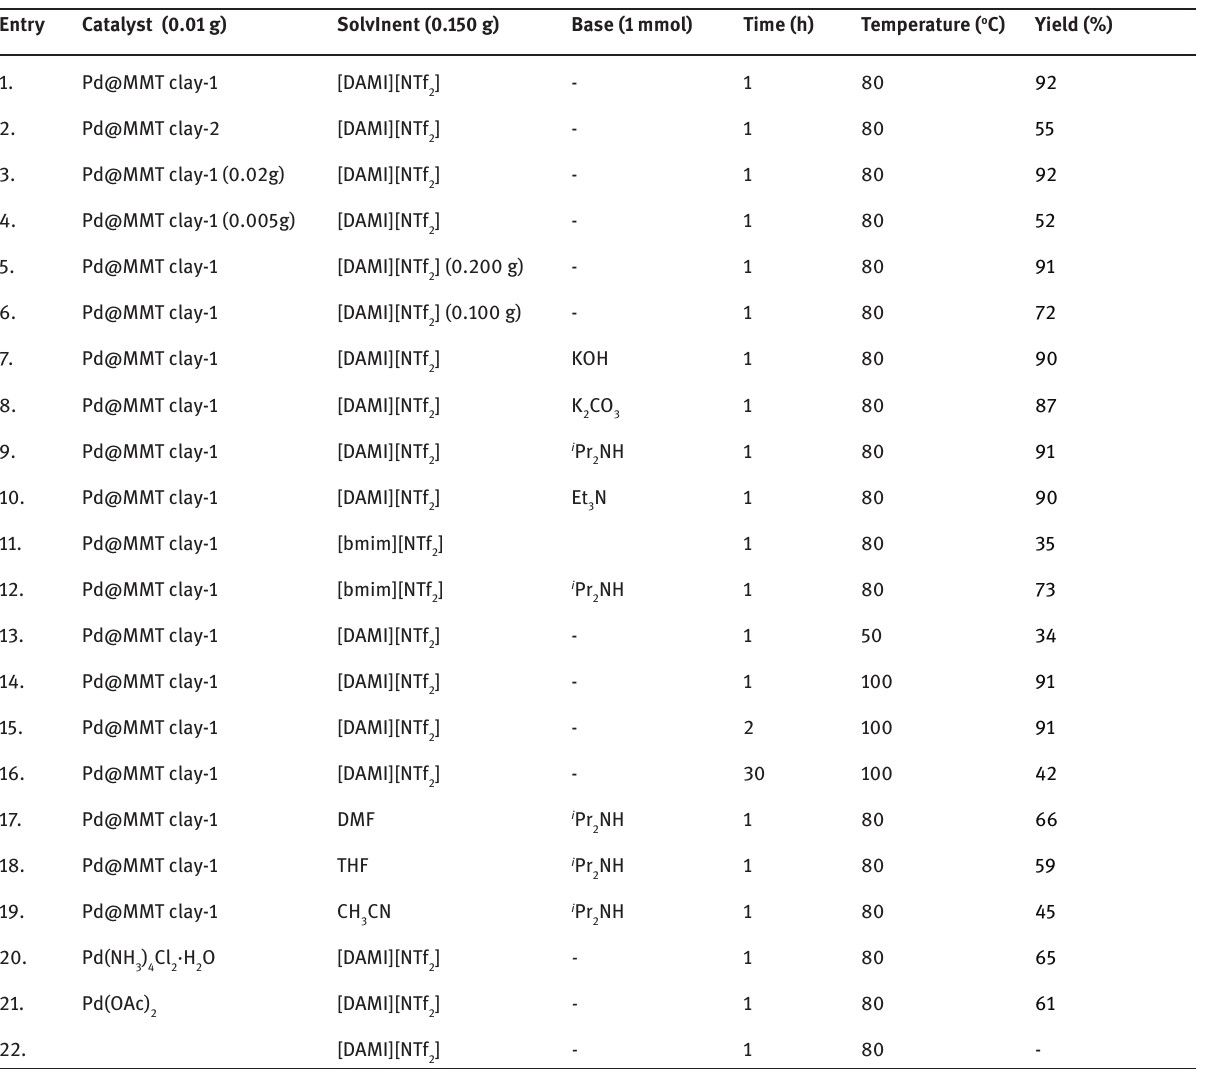
Table 2: Reaction optimization of Mizoroki Heck